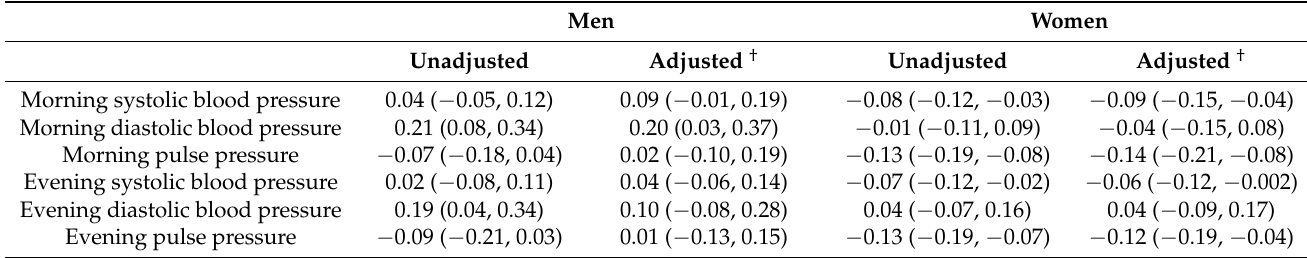
Table 2. Unadjusted and adjusted regression analyses on handgrip